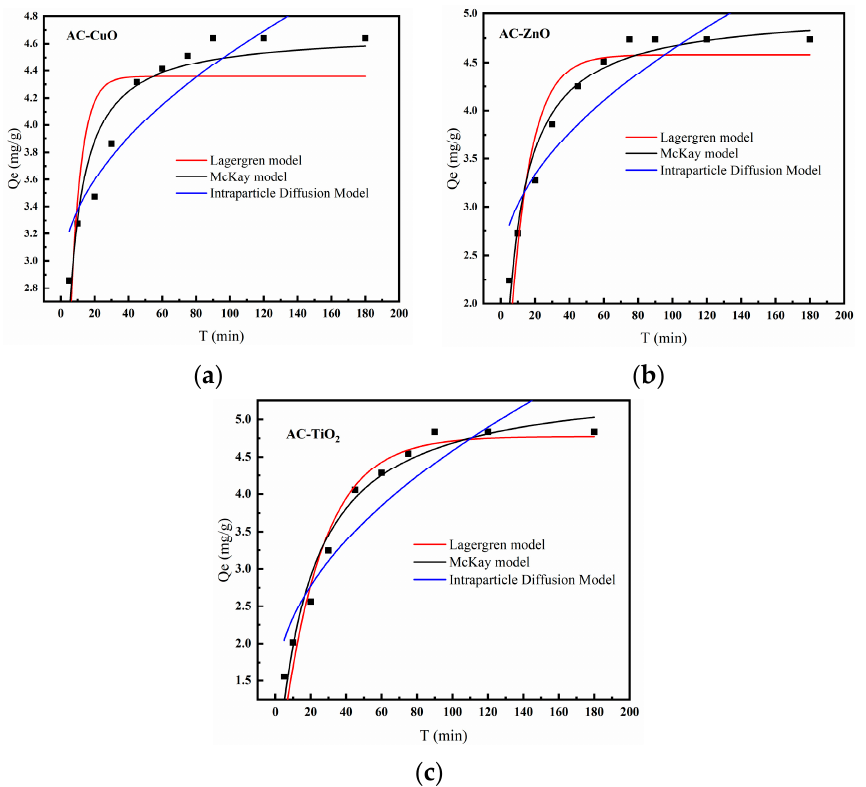
Figure 15. Kinetics model of ( a ) AC-CuO, ( b ) AC-ZnO, and ( c ) AC-TiO 2 . Table 4. Summary of correlation coefficients for kinetic model fitting.